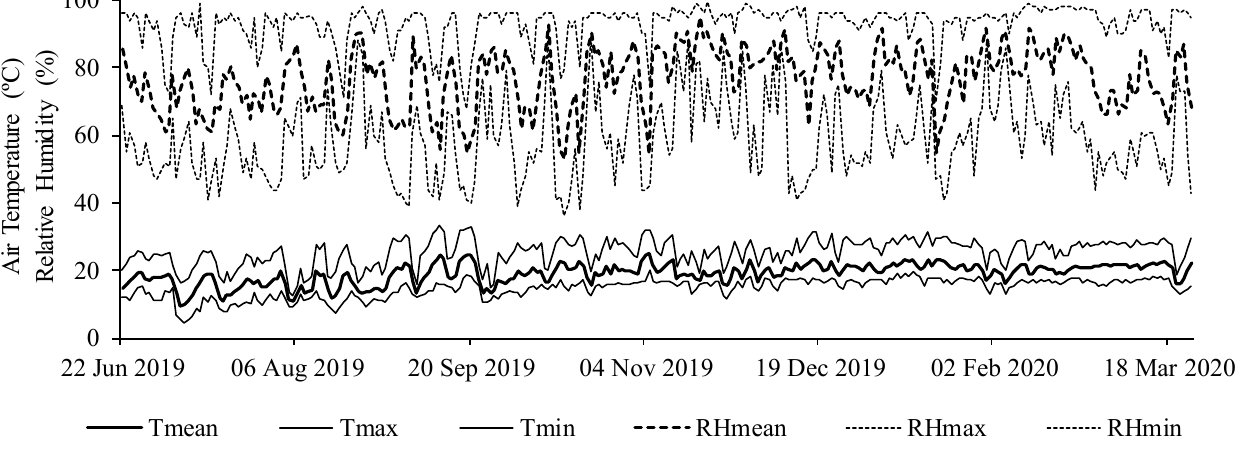
Figure 1. Daily variation of minimum (Tmin), mean (Tmean), and maximum air temperature (Tmax); the minimum (RHmin), mean (RHmean), and maximum relative humidity (RHmax) during the experimental period.